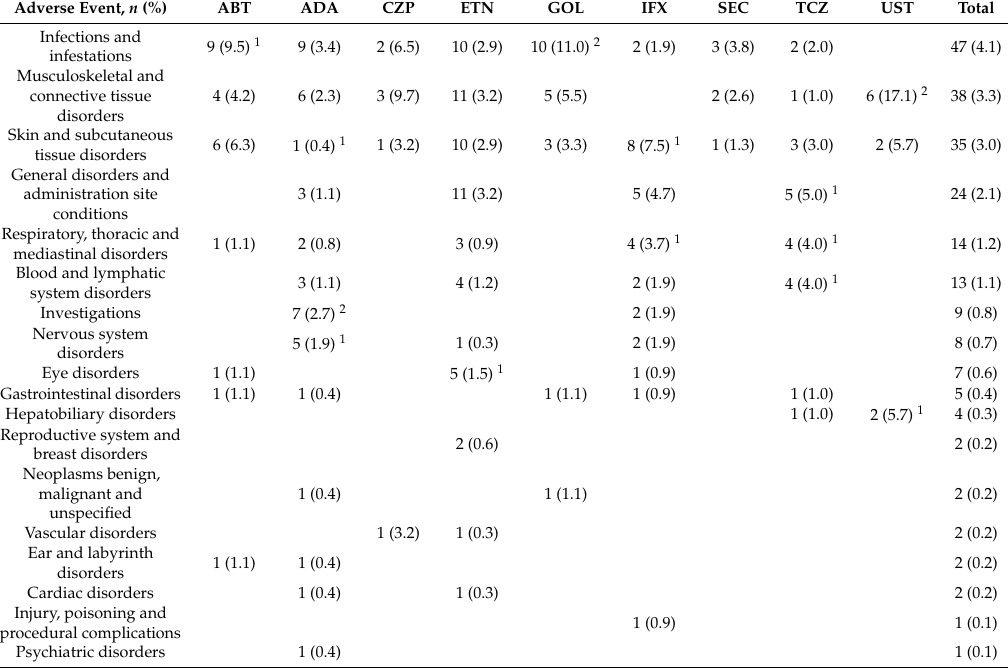
Adverse event distribution by bDMARDs according to MedDRA ® System Organ Class